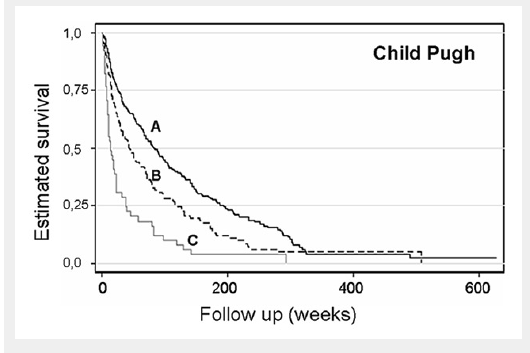
table 4: 1.2% for BCLC 0 and 33.1%, 19.4%, 34.9% and 11.4%, respectively, for the stages A–D, and table 5: 27.1% for CLIP 0 and 32%, 20.2%, 10.6%, 6%, 3.5%, 0.6%, re- spectively for the stages 1–6.) All patients had <30 MELD